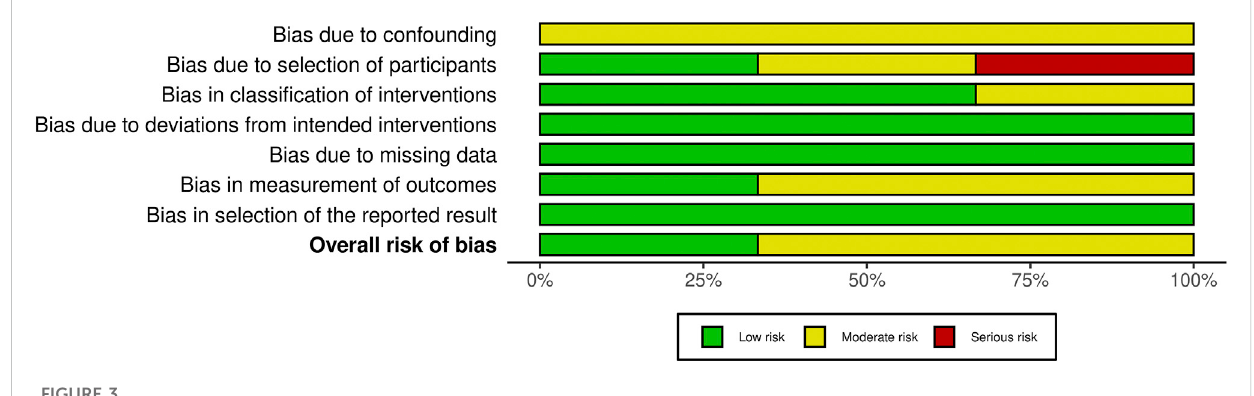
FIGURE 3 Risk of bias of observational studies using